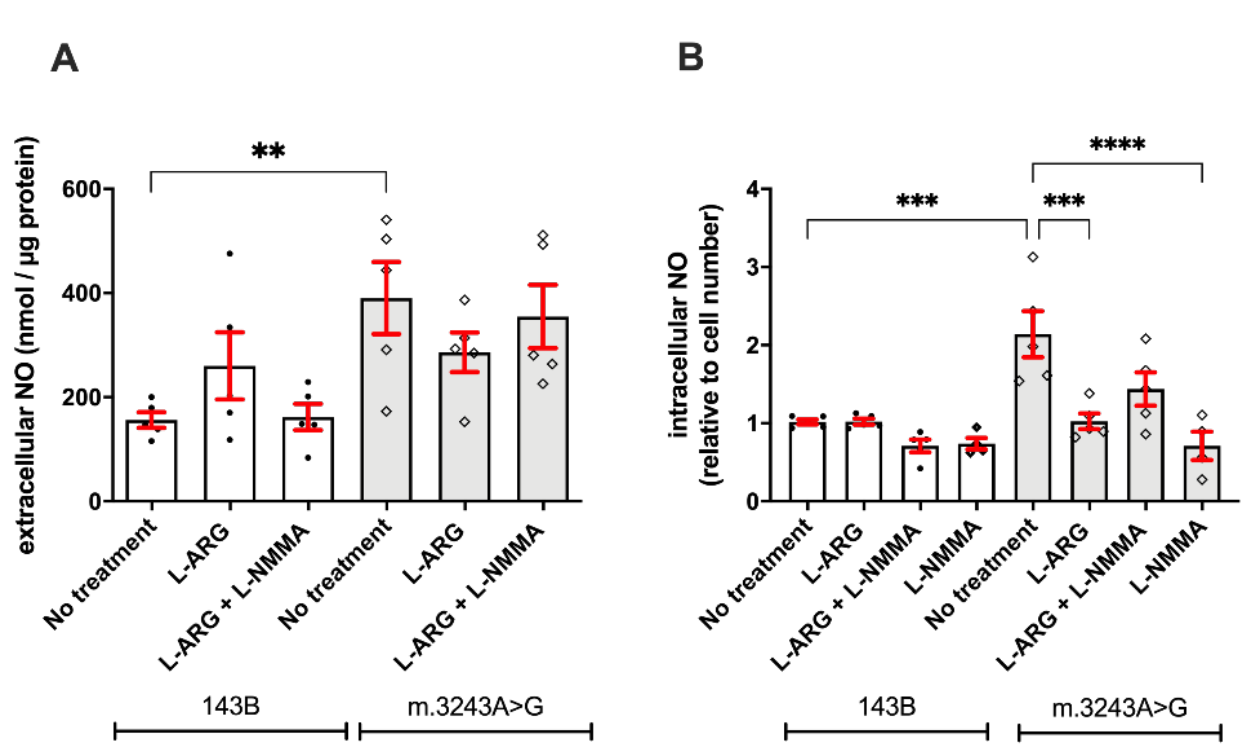
Figure 4. L-ARG and L-NMMA decrease the intracellular NO in MELAS cells. Determination of NO content was conducted in the culture medium of cells treated with L-ARG, L-ARG + L-NMMA. Cells with no treatment served as controls. The basal level of extracellular NO was significantly increased in m.3243A>G ( p = 0.007, one way ANOVA) when compared to 143B cells ( A ). However, no significant differences were observed after treatment with L-ARG or the combination of L-ARG and L-NMMA in both cell lines. Intracellular NO was quantified using an NO-fluorescent indicator (DAF-FM), corrected by cell number using Hoechst dye. At basal condition, m.3243A>G cells had increased intracellular NO concentration compared to 143B cells ( B ). Treatment with L-ARG or L-NMMA did not change the intracellular NO in 143B cells but decreased the intracellular NO in m.3243A>G cells. L-NMMA significantly decreased the intracellular NO in m.3243A>G cells, suggesting that most NO originated from NOS. Statistical analysis was performed using two-way ANOVA followed by Tukey’s post hoc test. White bars = 143B cells; gray bars = m.3243A>G. ** p ≤ 0.01; *** p ≤ 0.001; **** p ≤ 0.0001.